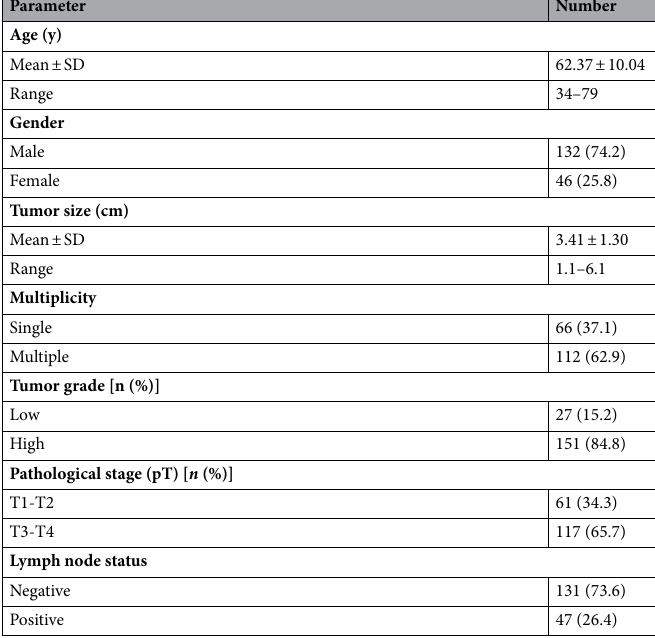
Table 1. Clinicopathological parameters of 178 patients with urothelial carcinoma of the